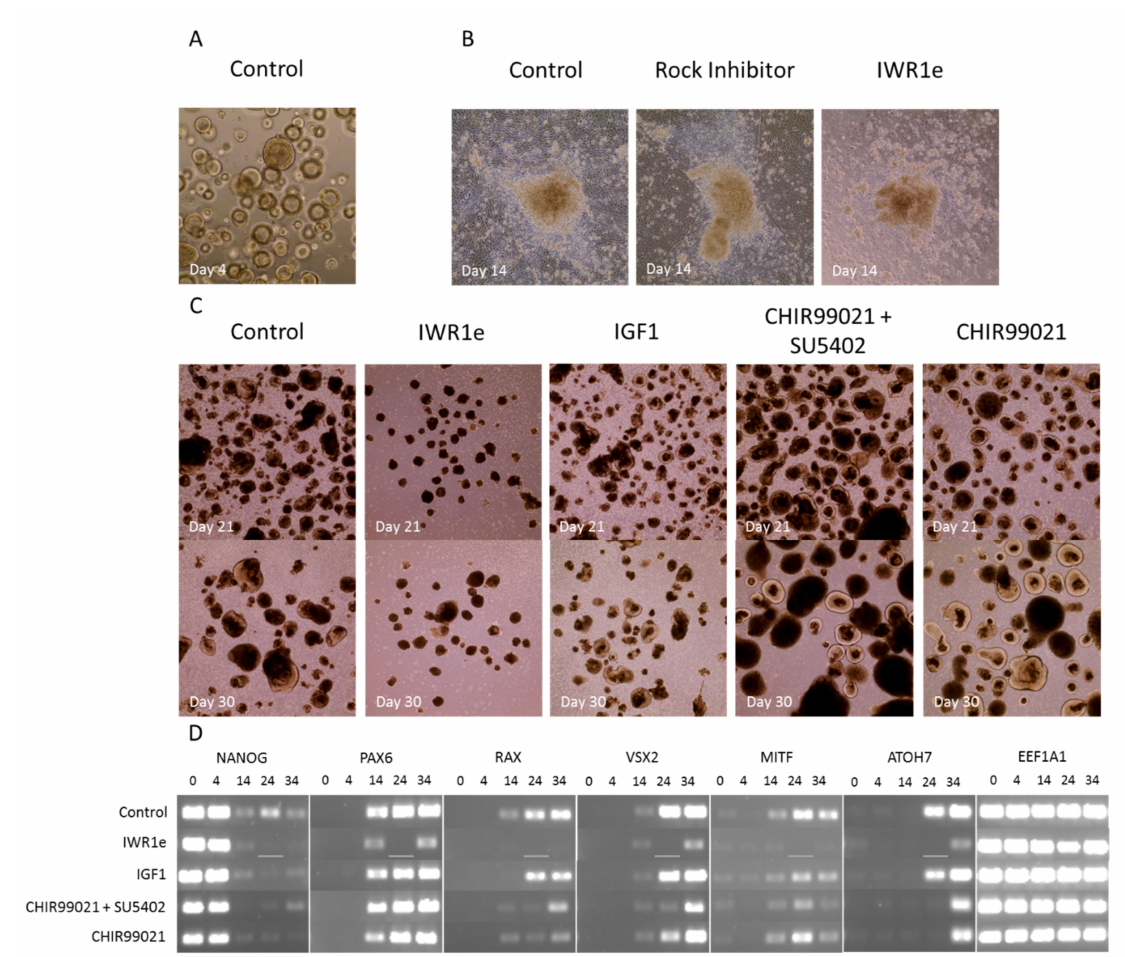
Figure 10. Changes in retinal development through microscopy and gene expression assay. ( A ) All conditions developed comparable embryoid bodies to the control up to day 4. ( B ) Throughout the next 2D stage of generating neurospheres (day 4–14), changes between conditions were observed. Rock Inhibitor-treated cells had two distinct types of epithelial outgrowth, with a border separating them, whereas IWR1e-treated cells resulted in poor epithelial outgrowth and an increase in cell death. ( C ) Only IWR1e, IGF1, CHIR99021 + SU5402, and CHIR99021 treatments showed significant changes in retinal organoid yield compared to the control. IWR1e treatment severely impact retinal organoid yield and the overall organoid size. Continuous IGF1 treatment resulted in almost double the number of retinal organoids compared to the control. CHIR99021/SU5402 double treatment increased retinal organoid yield 2.5-fold; however, individual CHIR99021 treatment gave the best yield with a 5-fold increase. ( D ) The differences between conditions were also largely reflected in the gene expression of key developmental markers such as PAX6 , RAX and VSX2 , as well as cell-specific markers such as MITF and ATOH7 . Differences of retinal development genes were observed between conditions over time (Day 0, 4, 14, 24, 34). Unfortunately, IWR1e treatment resulted in poor organoid yields and subsequently, there was less RNA available for day 24, as represented by the EEF1A reference gene